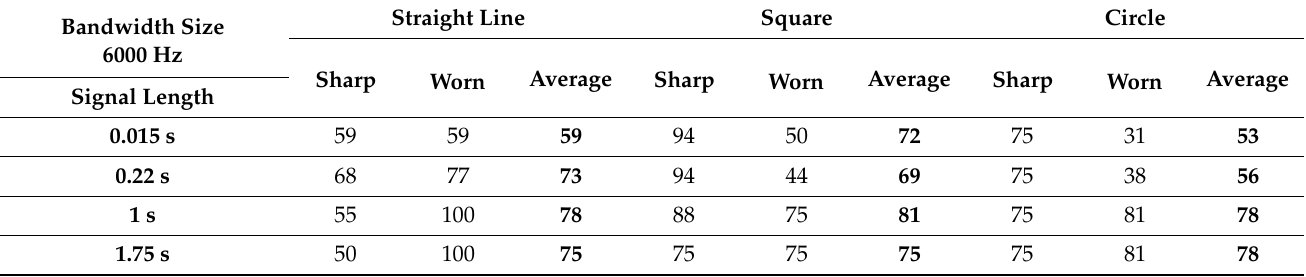
Table 6. Tool wear classification rate with AE signals and various signal lengths (model trained by straight line